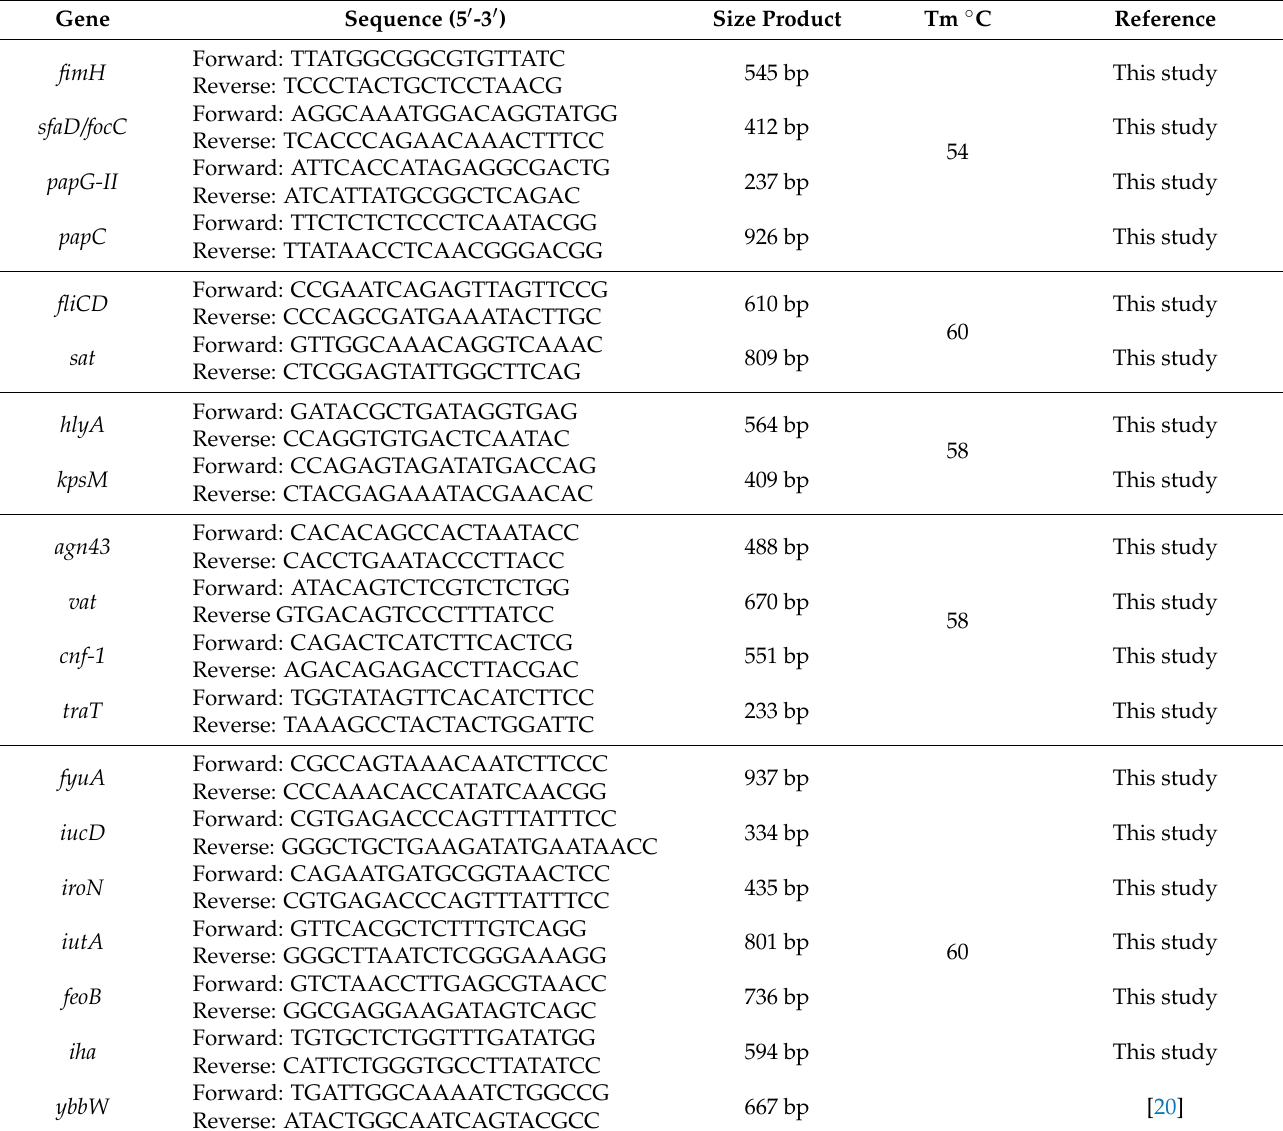
Table 1. Primers used for the detection of virulence associated genes and molecular identification of clinical isolates of E. coli